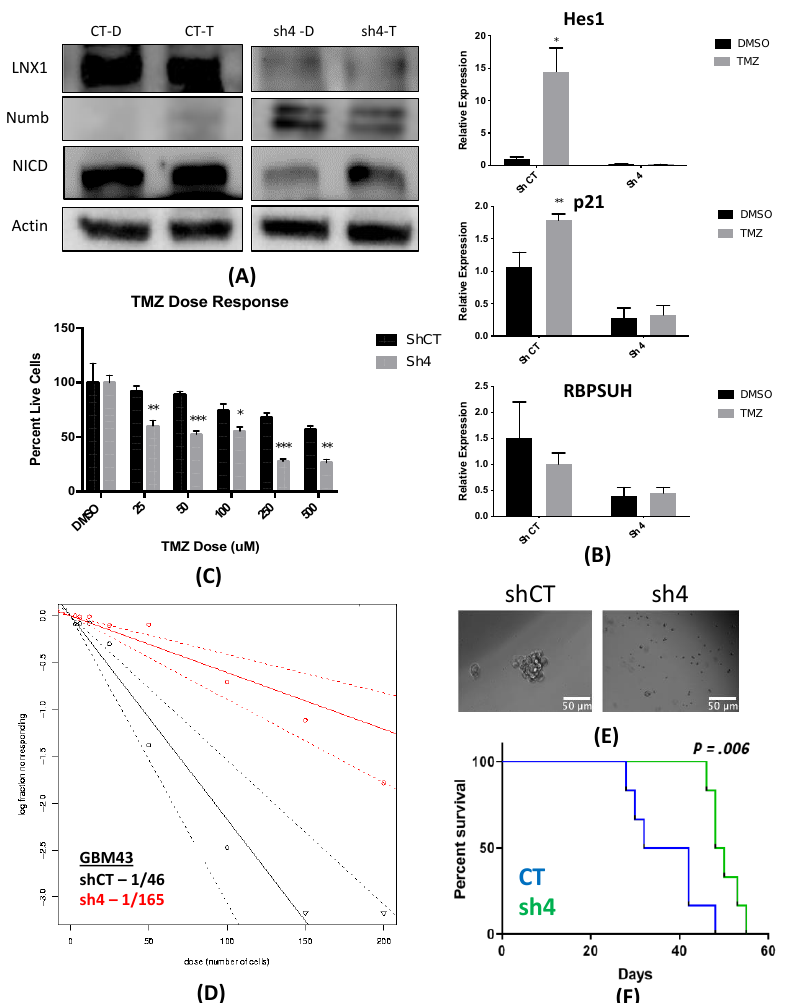
Figure 6. Knockdown results in notch downregulation, reduced stemness, and longer survival. ( A ) LNX knockdown results in increased Numb and reduced Notch1 activation with TMZ therapy, where D represents DMSO and T represents TMZ therapy. ( B ) Knockdown of LNX1 resulted in reduced activation of Notch1 downstream markers, as measured by quantitative PCR. ( C ) LNX1 knockouts were increasingly sensitive to TMZ as compared to controls exposed to the same doses. ( D ) Limiting dilution assays in showed that the knockdown was no longer able to induce stemness. ( E ) Representative images showed sphere formation controls but limited sphere formation in our knockdowns. ( F ) LNX1 knockdown in our animal tumor model showed significant increases in survival over our control population. Statistical analysis was performed in Prism 8, using the Student’s t-test to compare 2 groups or ANOVA for more than 2 groups. Chi-squared testing was used to calculate significance for limiting dilution assays and log-rank testing was used to compare survival curves. * p < 0.05; ** p < 0.01; *** p < 0.001.